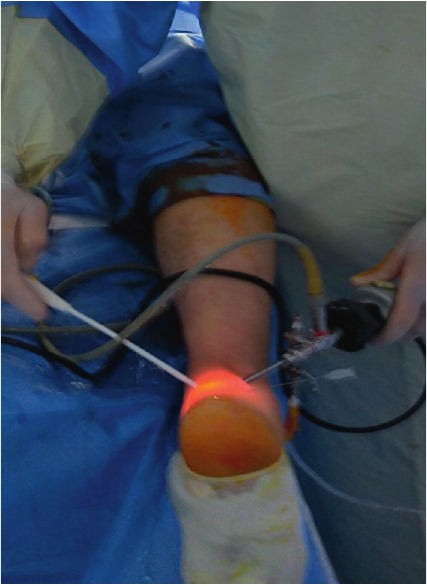
Figure 3: Patient is lying prone intraoperatively. The procedure was performed through medial and lateral portals.